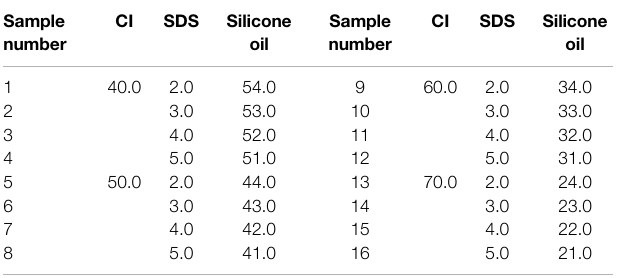
TABLE 1 | The constituent of MRF with